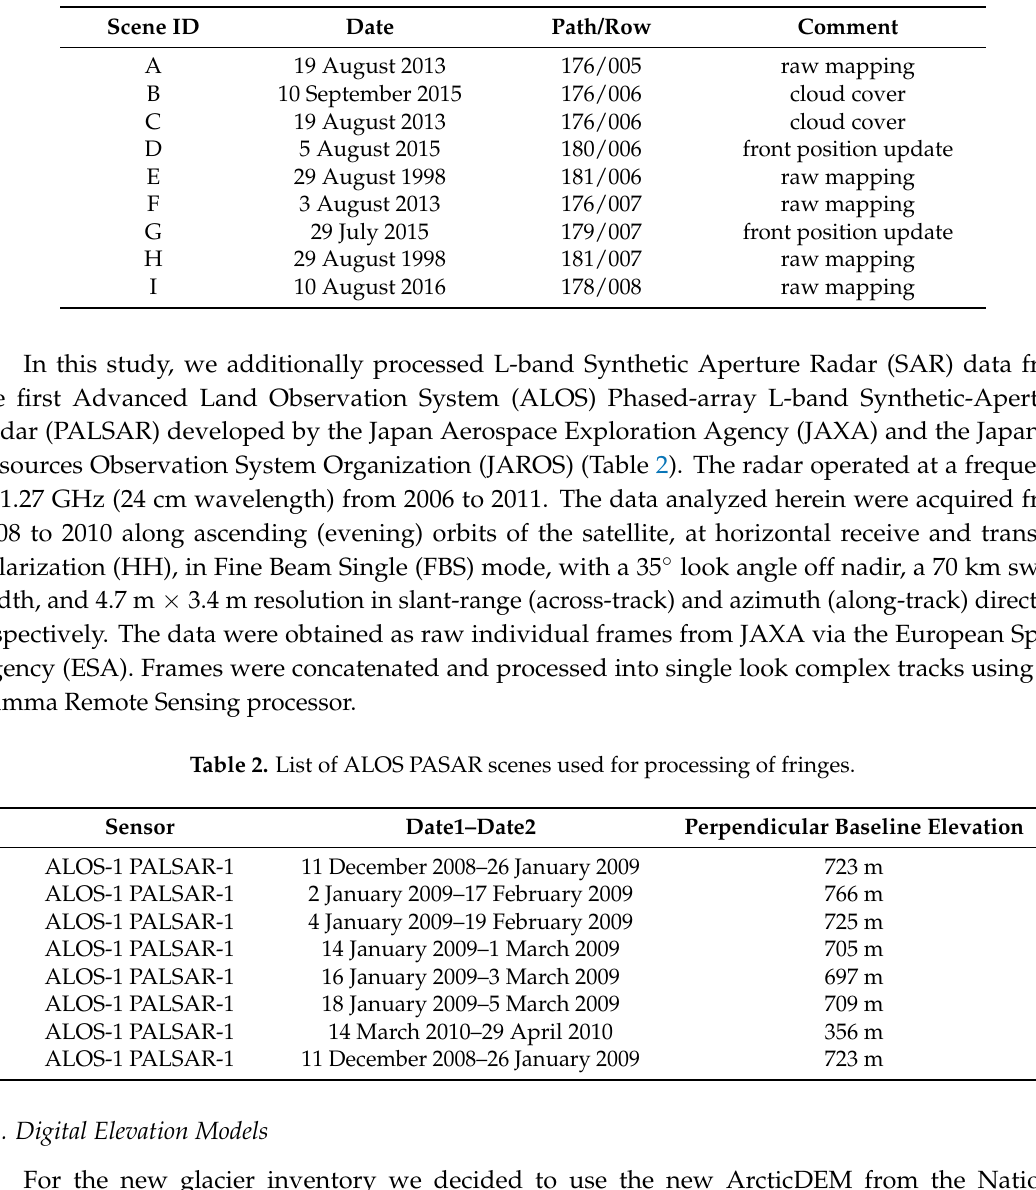
Table 1. Landsat 8 and 5 satellite scenes and its application in this study.